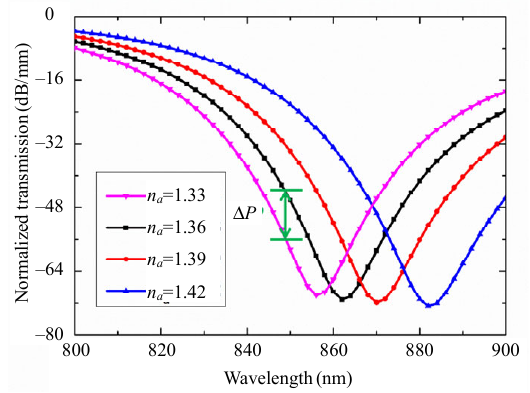
Fig. 3 Normalized transmission as a function of the wavelength when w = h = 3 μ m, d Au = 50 nm, and t b = 500 nm.